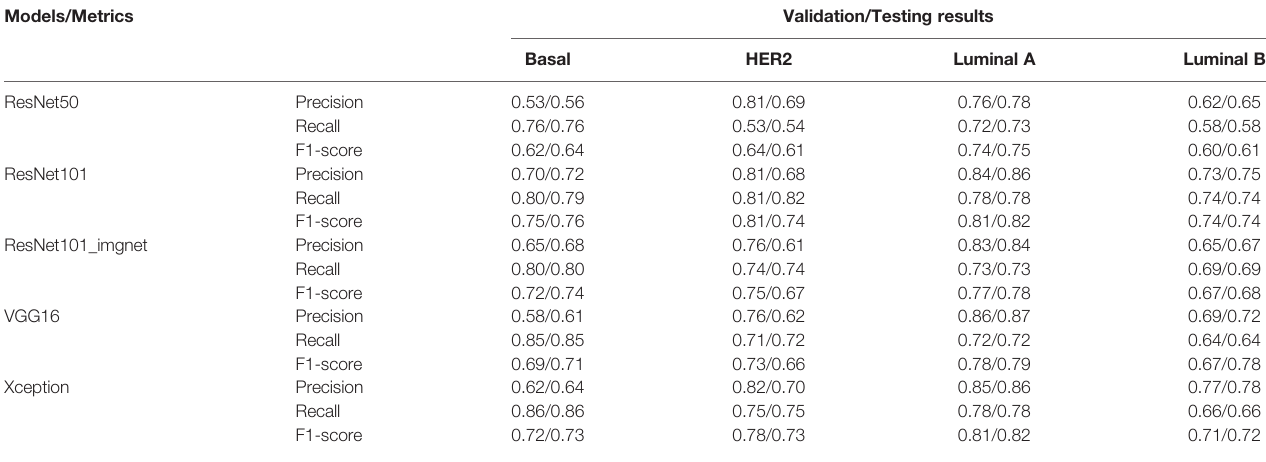
TABLE 2 | Patch-wise model performance on the validation and testing sets.